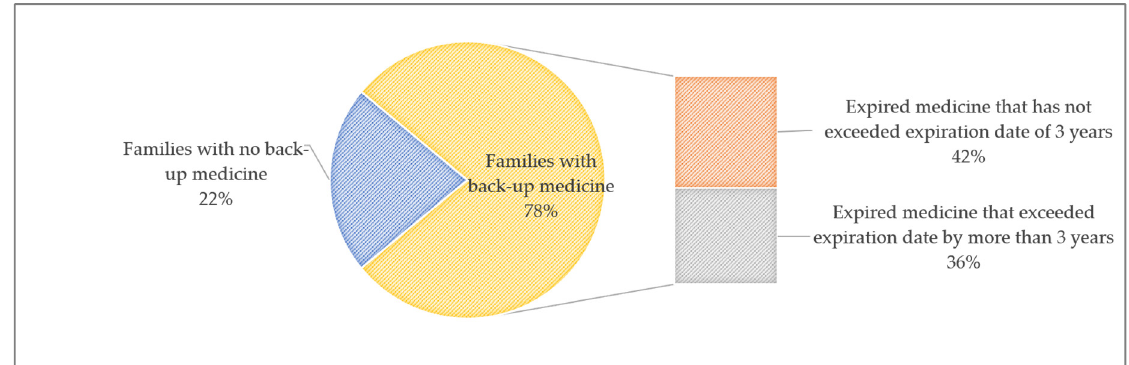
Figure 1. The proportion of expired medicines in Chinese households. Source: The White Paper on the Recycling of Expired Medicines in Chinese Families (2004–2014) .